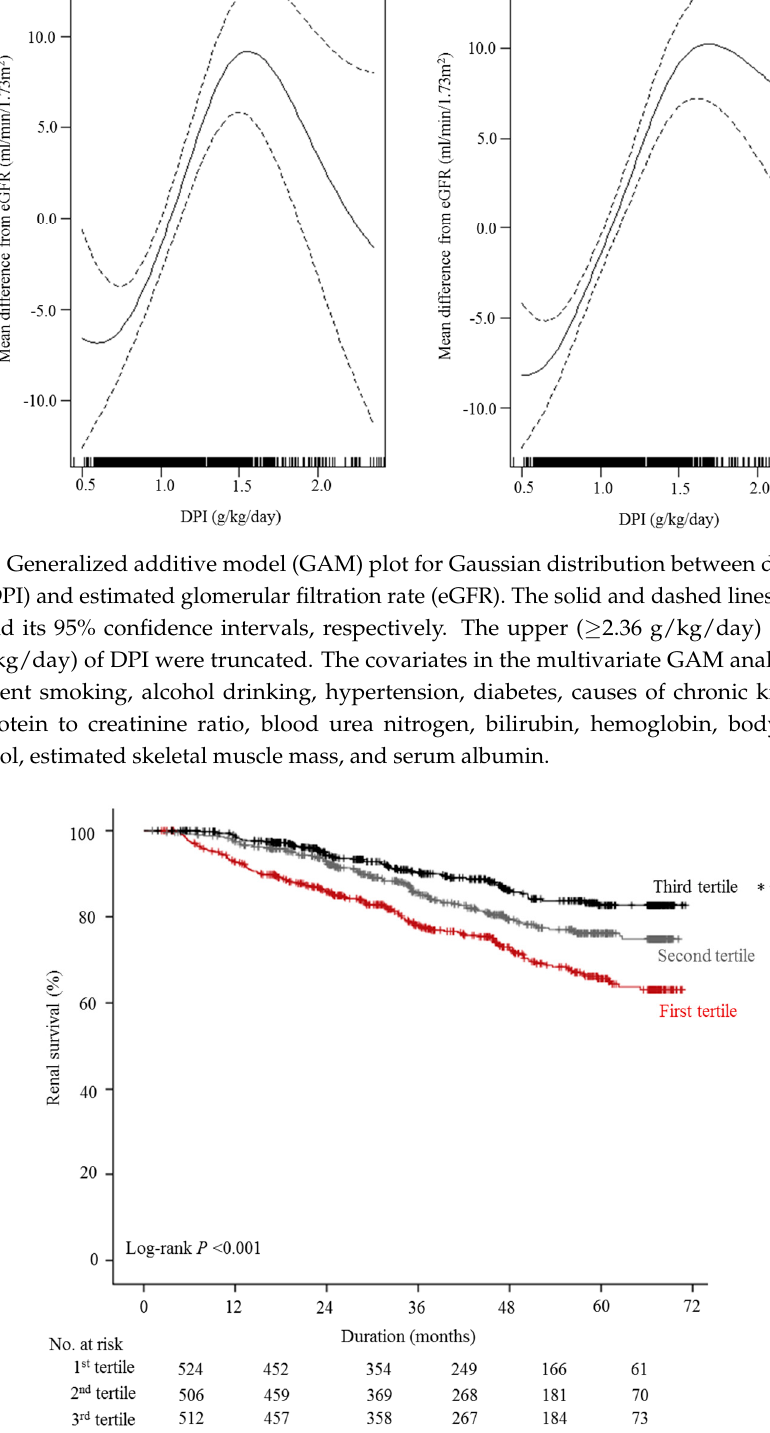
Figure 2. Kaplan–Meier survival curve of tertiles of dietary protein intake (DPI). * and † indicate p < 0.05 when compared to the first and second tertiles of the DPI group, respectively, using the log-rank test.